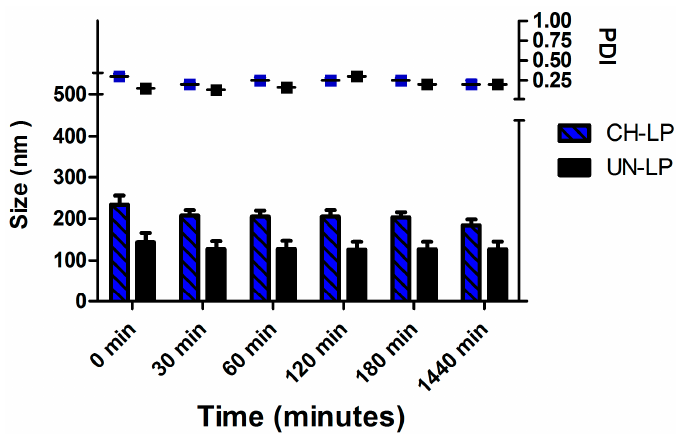
Figure 2. Stability assay of chitosan-coated liposomes (CH-LP) and uncoated liposomes (UN-LP) over 24 h in PBS medium.